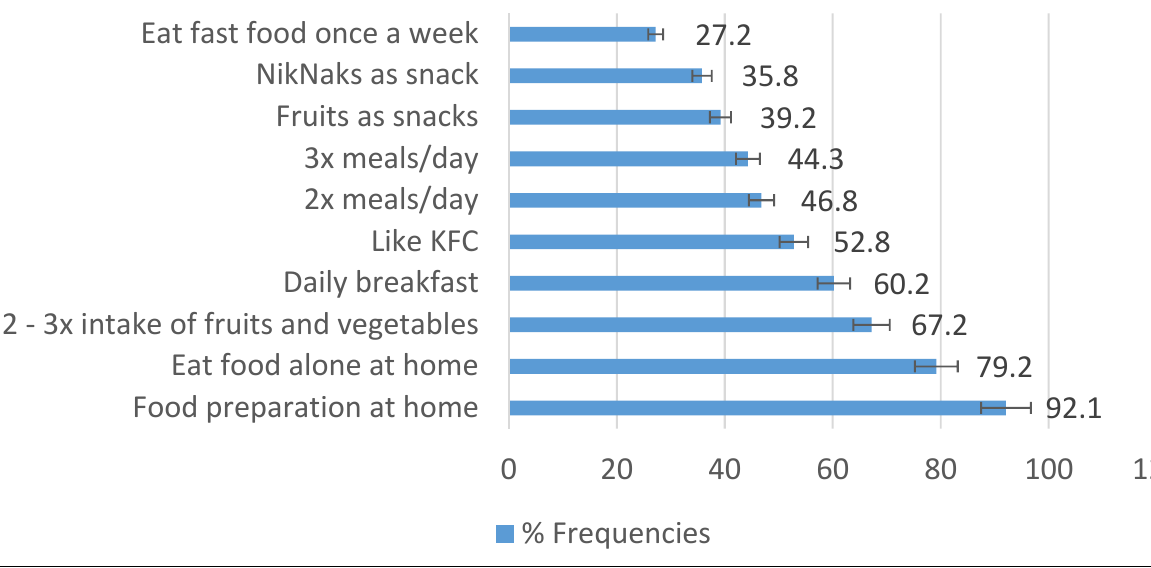
Figure 1: Distribution of body mass index by gender ( n =640).